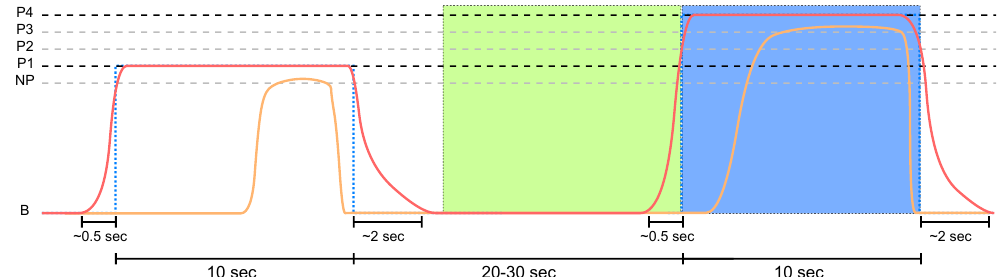
Figure 5. Sensor data segmentation of 10 s non-painful (green area) and painful (blue area) windows for the PainMonit Database (PMDB). The windows are centred around the on and offsets of the temperature (red curve) stimulus. Moreover, the CoVAS (orange curve) values are used to create a pain label that incorporates the subjective sensation of the